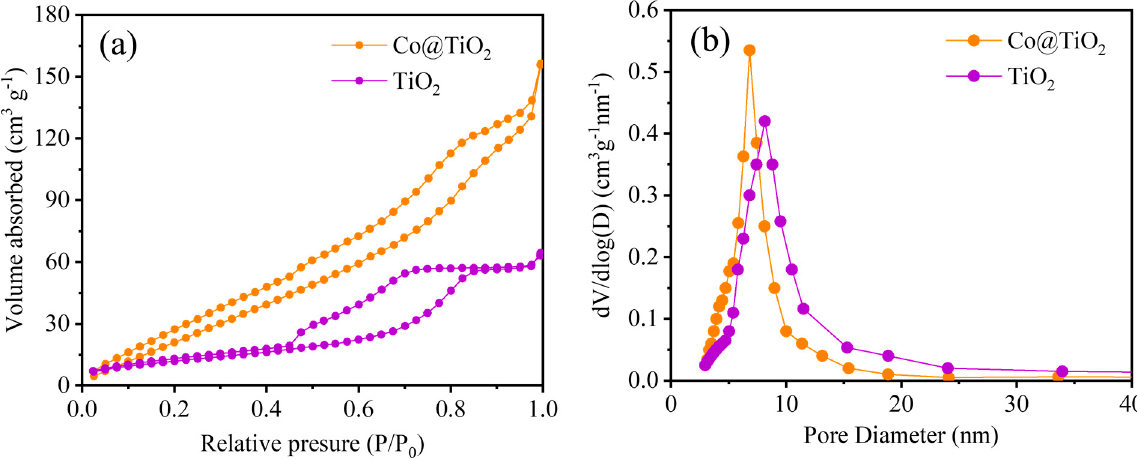
Figure 2. ( a ) N 2 adsorption–desorption curves and ( b ) pore size distribution of TiO 2 and Co@TiO 2